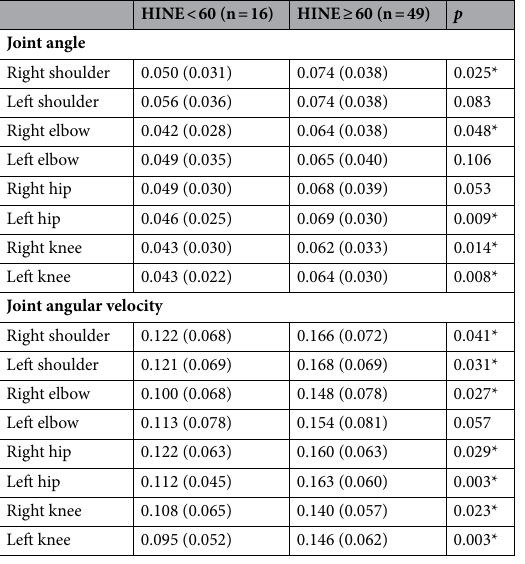
Table 3. Comparison results of complexity indices for joint angle and joint angular velocity between preterm infants with Hammersmith Infant Neurological Examination (HINE) < 60 and those with HINE ≥ 60. Values are presented as mean (standard deviation). *p <